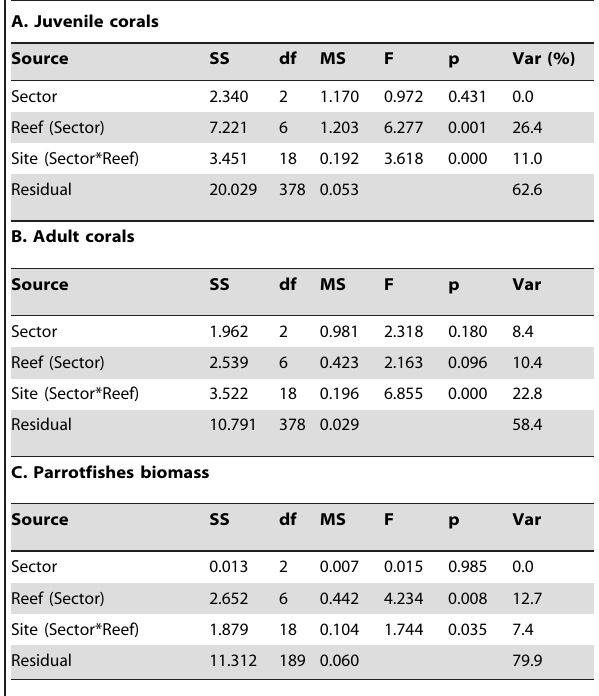
Table 1. Results of hierarchically-nested ANOVAs examining variation in (A) density of juvenile corals, (B) adult coral cover, and (C) biomass of scraping and excavating parrotfishes, among latitudes, reefs, and sites.